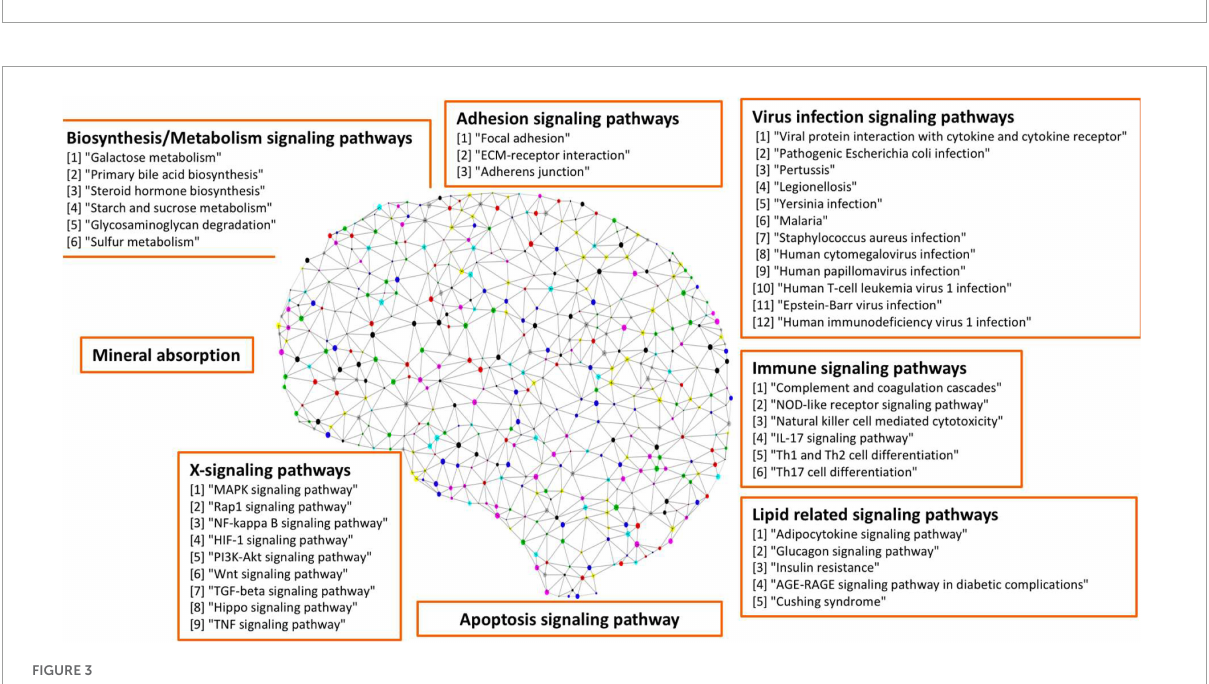
FIGURE3 Seven categories of weakly activated signaling pathways in